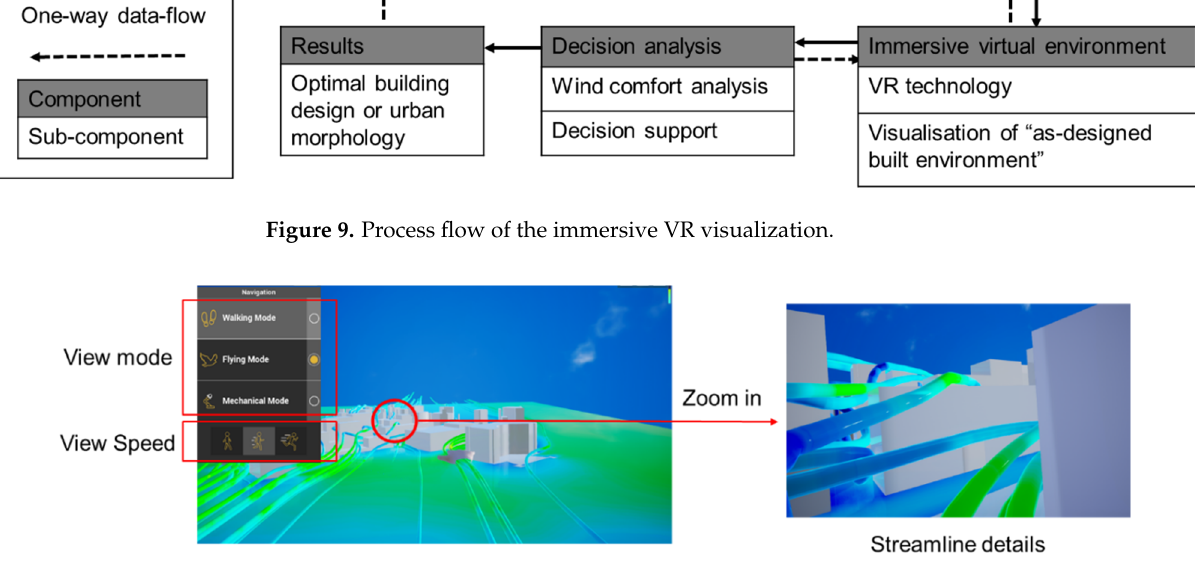
Figure 10. Screenshot of the visualization of CFD-computed results.